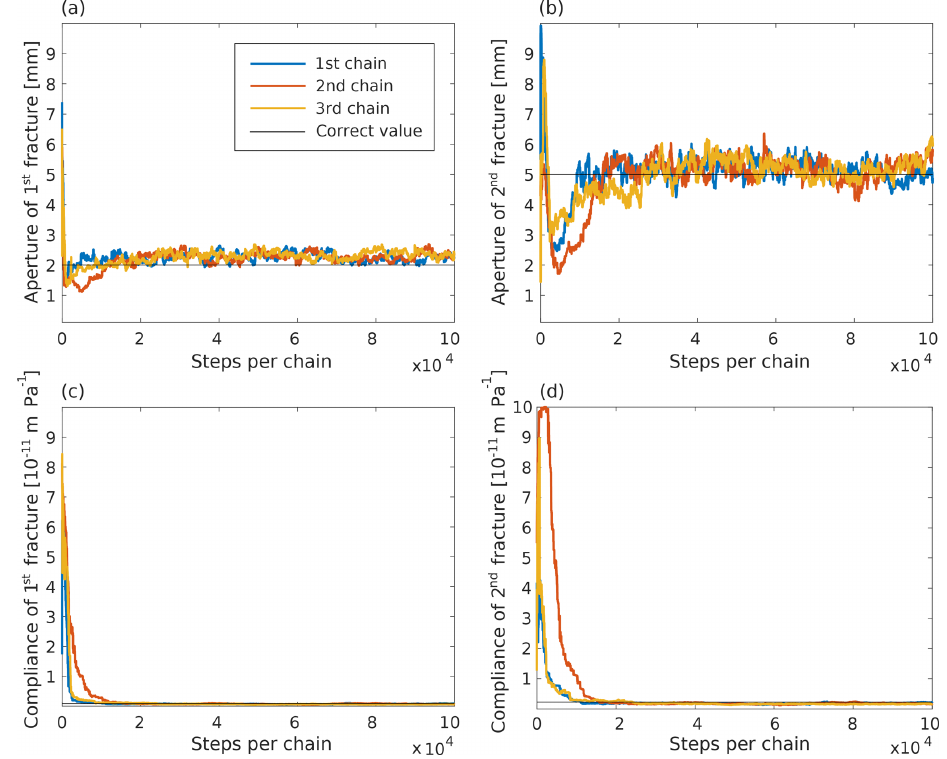
Figure 2. Estimates of (a–b) the aperture and (c–d) the compliance of the two fractures as functions of the number of forward modeling steps. The horizontal black lines denote the corresponding values used to generate the synthetic data shown in Fig.